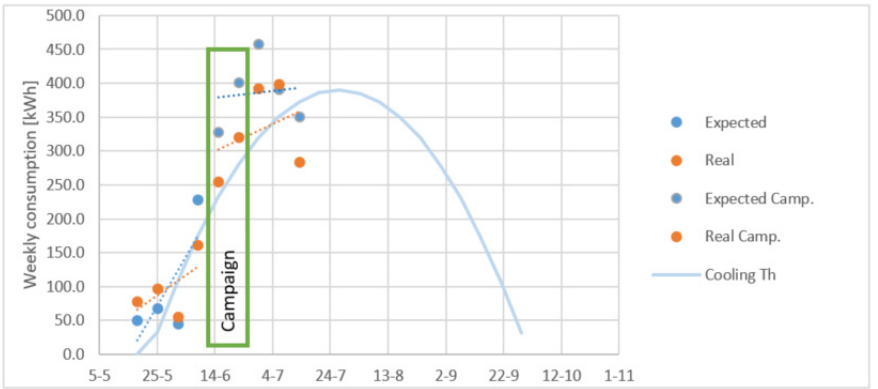
Figure 3. Data of weekly energy use for cooling before, during and after the campaign in summer. The points are drawn over a curve representing theoretical energy use for heating due to weather.